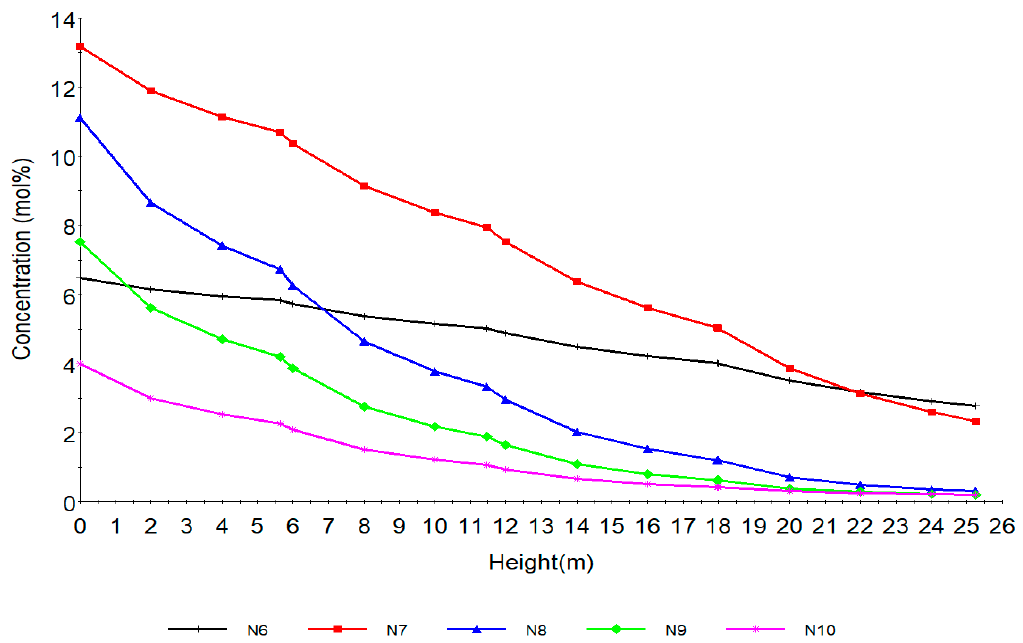
Figure 5. Concentration profile of naphthenes with total height of reactors.